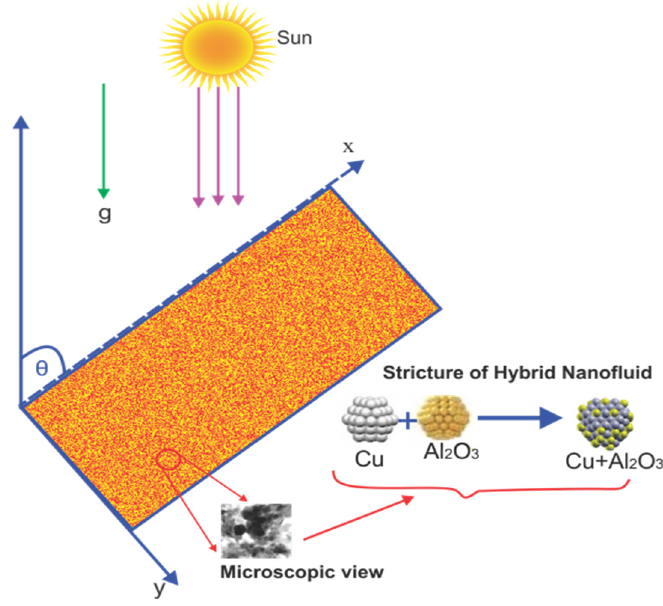
Figure 1. Solar collector schematic model. is considered with slip physical conditions. In addition, energy formulation takes into the temperature of the wall and T ∞ the free stream. The basic governing equations for the Darcy–Forchheimer flow are written as.